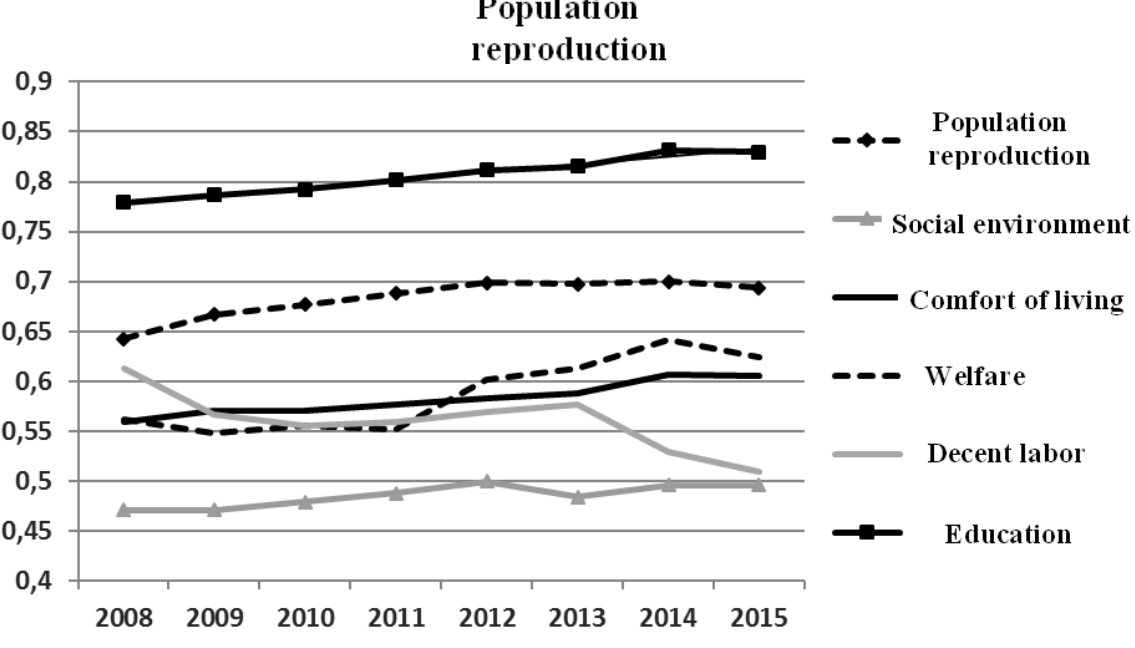
Fig. 2. Dynamics of indices by various aspects of human development in the regions of Ukraine, 2008-2015 Source: figure is developed based on the methods of calculating a regional human development index [17].